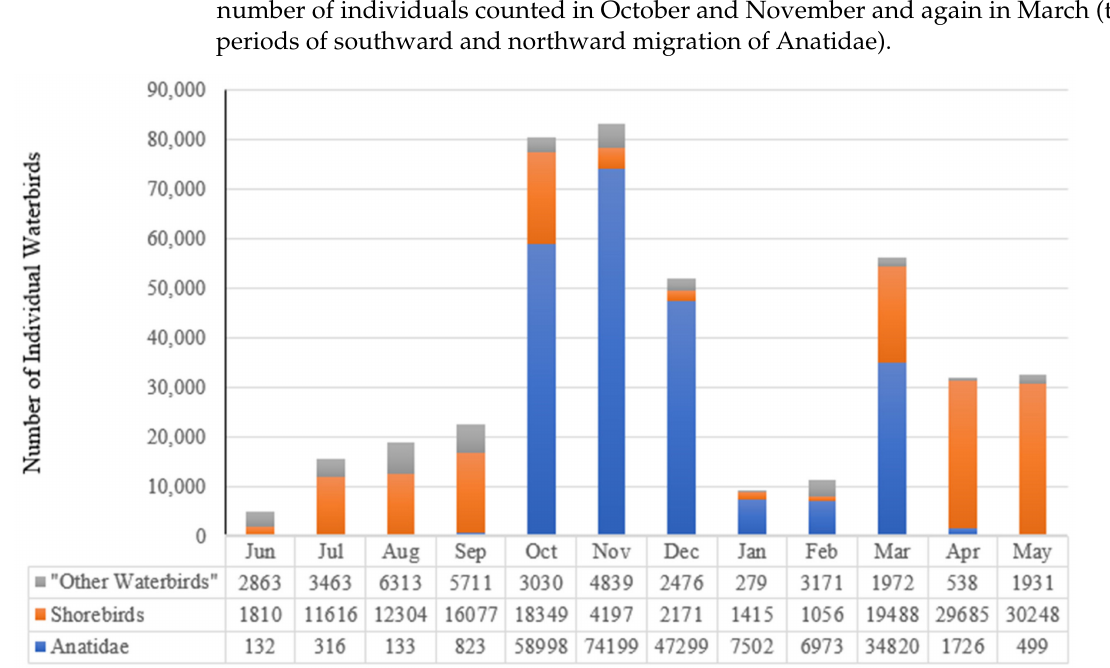
Figure 4. Number of individual waterbirds recorded by month during the Project Surveys, subdivided into three main groups of Anatidae, Shorebirds and “other Waterbirds” at the Hwaseong Wetlands FNS and adjacent Maehwari Tidal Flat in 2020 and 2021.